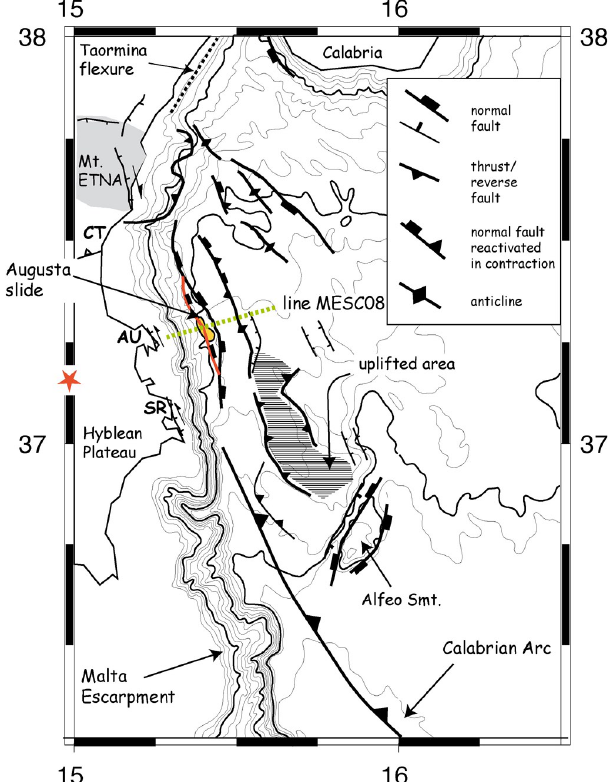
Fig. 2. Bathymetry of the eastern Sicily offshore with the simplified structural map based on the MESC seismic survey (Argnani and Bonazzi, 2005). Onshore data are only schematic and are mainly taken from Lanzafame and Bousquet (1997) and Adam et al. (2000). The active fault is marked in red. The trace of seismic profile MESC 08 is indicated as a thick dashed green line, whereas the orange field represents the extent of the Augusta slide. The red star indicates the approximated location of the onshore 11 January 1693 earthquake epicenter suggested by CPTI Working Group (2004). CT, AU, and SR indicate the location of the cities of Catania, Augusta and Sira- cusa, respectively.